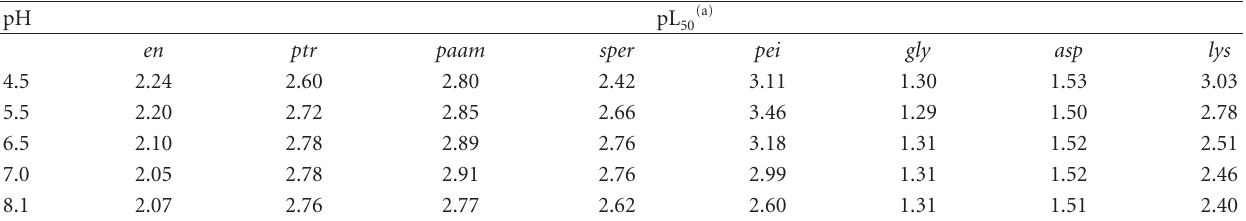
Table 9: pL values for the sequestration of dmt by various ligands, at I = 0 . 1 mol L − 1 , t = 25 ◦ C and di ff erent 50